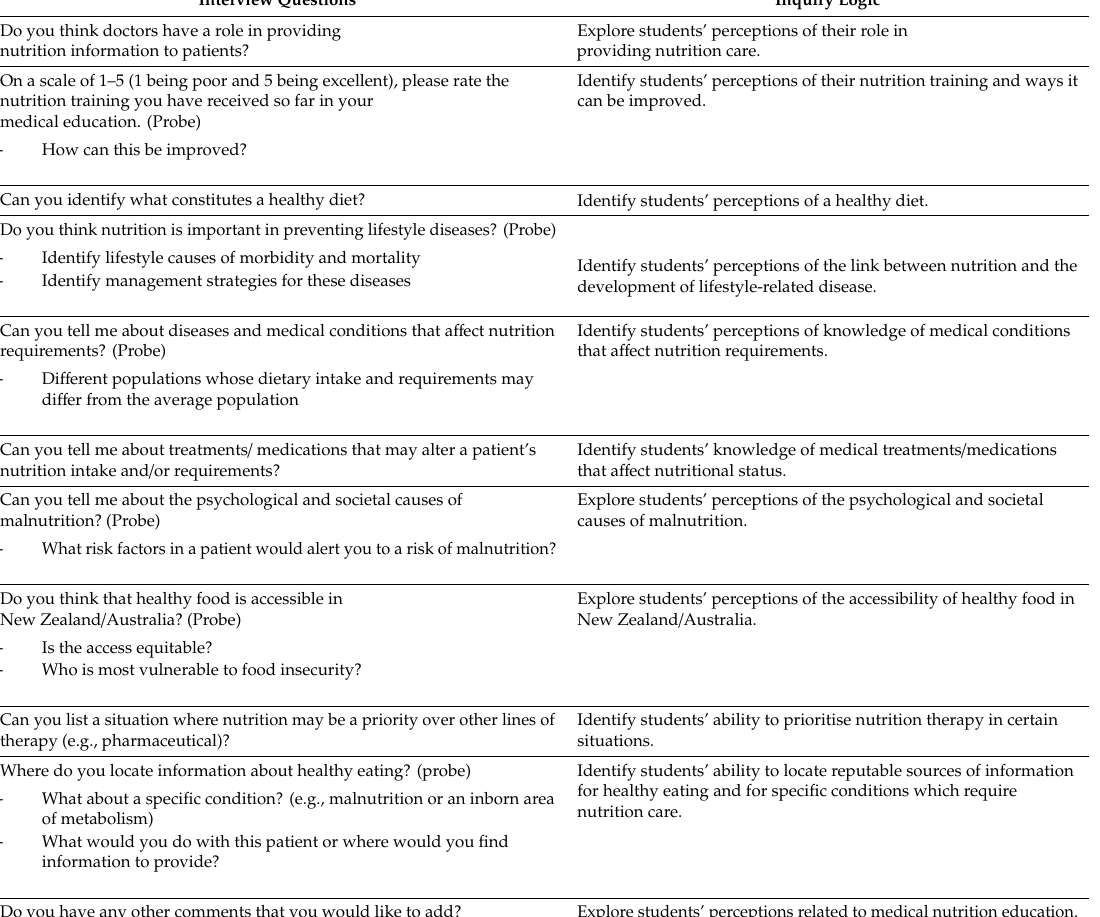
Table 2. Interview guide and inquiry